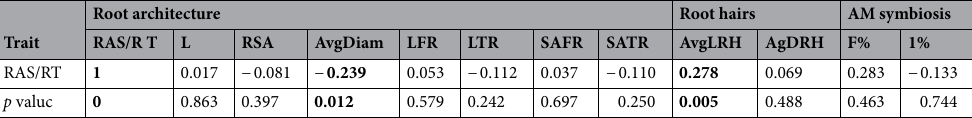
Table 1. Correlation matrix of root soil aggregation and root parameters. Value from 2 independent experiments on contrasted pearl millet lines using Spearman’s correlation test. Ratio (RAS/RT) between the mass of root-adhering soil (RAS) and root tissue biomass (RT), Total root length (L), Root Surface Area (RSA), Average Root Diameter (AvgDiam), Total Length of Fine Roots (LFR), Total Length of Thick Roots (LTR), Surface Area of Fine Roots (SAFR), Surface Area of Thick Roots (SATR), Average Length of Root Hairs (AvgLRH), Average Density of Root Hairs (AgDRH), Frequency of mycorrhization (F%), Intensity of mycorrhization (I%). Significant values are in bold.